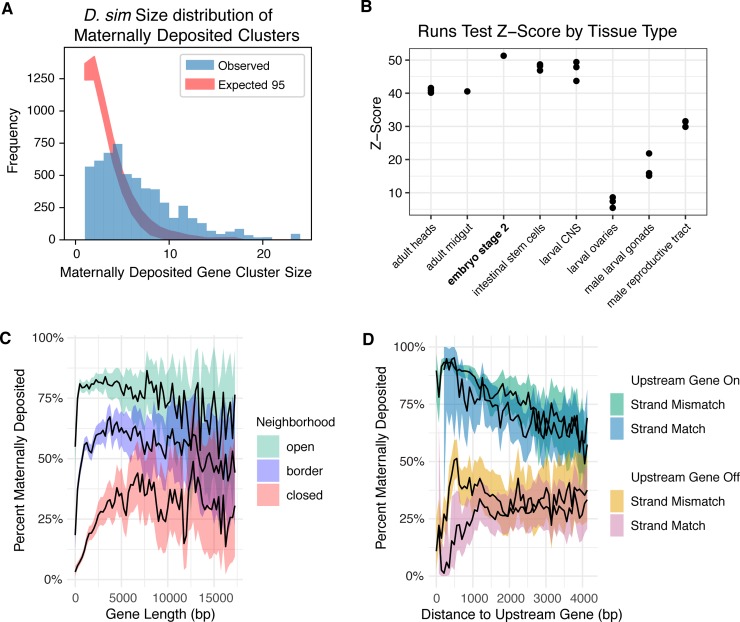
Maternal genes are found in co-expressed clusters.For the analyses in A and B, genes were categorized as either expressed or not expressed (see Methods) and adjacent expressed genes were considered to be clustered, with a cluster size equal to the number of constituent genes. (A) Physical clustering of maternally deposited genes along the chromosome, in a representative species (D. simulans). The shaded blue region represents the observed frequency of co-expressed maternal gene clusters of various sizes. The red region represents the 95% CI constructed with 10,000 bootstrap iterations. Maternal genes are co-expressed in clusters along the chromosome more often than expected, given the percent of the genome that is transcribed at this stage. (B) Physical clustering of co-expressed genes on chromosomes in various tissue types. In order to compensate for differing proportions of the genome that are expressed in each tissue type, physical clustering was measured by performing a Wald-Wolfowitz runs test and taking the z-score (see Methods). Maternally expressed genes, represented by stage 2 embryos, show the highest proportion of physical clustering of co-expressed genes, though other tissues such as intestinal stem cells and larval CNS also have highly physically clustered co-expressed genes. (C) Gene length by number of adjacent maternally expressed genes, "open" indicating both adjacent genes are expressed, "border" indicating that one is expressed, and "closed" indicating that neither are expressed. Genes that with more expressed neighbors are more likely to be maternally deposited, regardless of length. Genes without expressed neighbors are less likely to be maternally deposited, with the odds increasing as length increases. (D) Odds of maternal deposition versus distance to the nearest upstream gene by upstream expression and strand. Distance is measured by from transcription start site (TSS) to TSS. When the upstream gene is maternally deposited, odds of maternal deposition are high, but decrease with distance regardless of strand. When the upstream gene is not maternally deposited, odds of maternal deposition are low and have a strand-dependent relationship with distance.